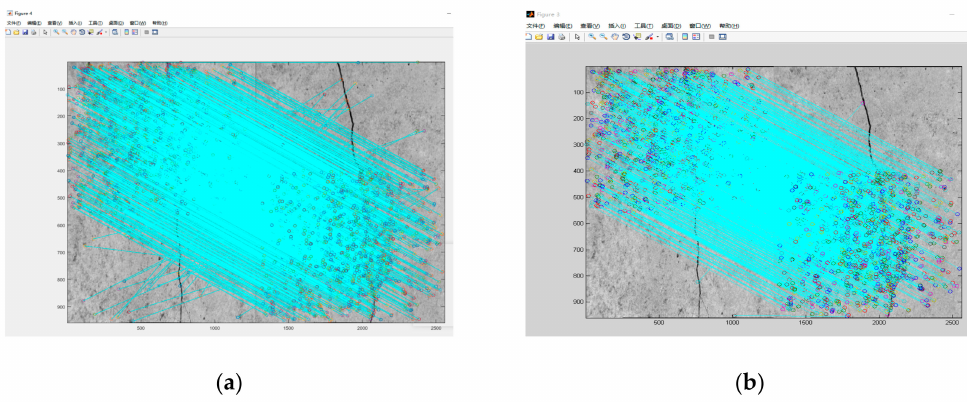
Figure 13. Feature point matching: ( a ) left figure and ( b ) right figure.